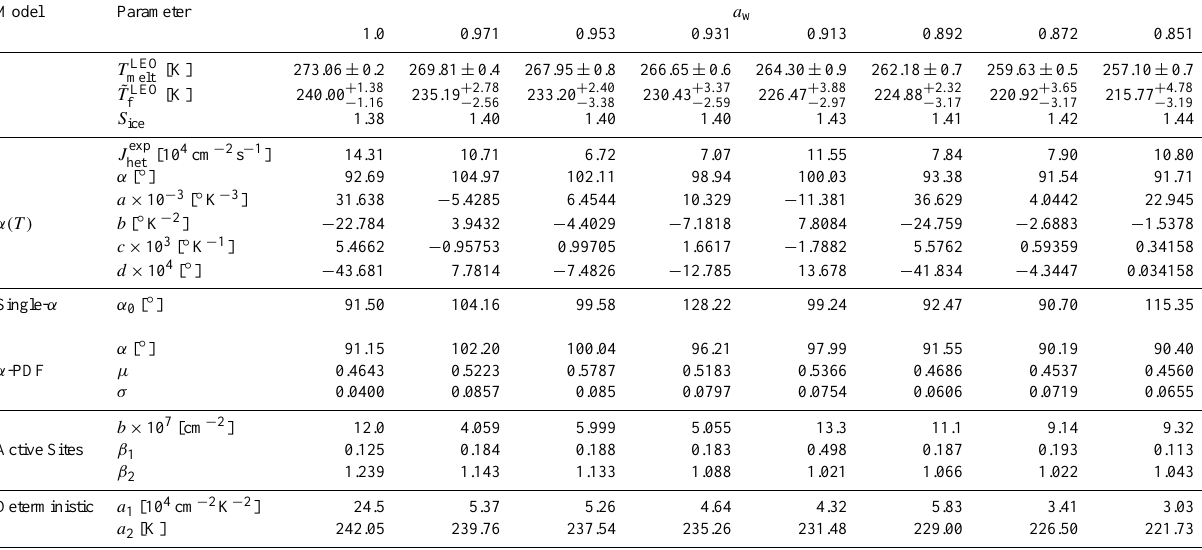
, ± 1 σ ), median freezing temperature ( ˜ T LEO melt ); heterogeneous ice nucleation rate coefficient ( J exp f